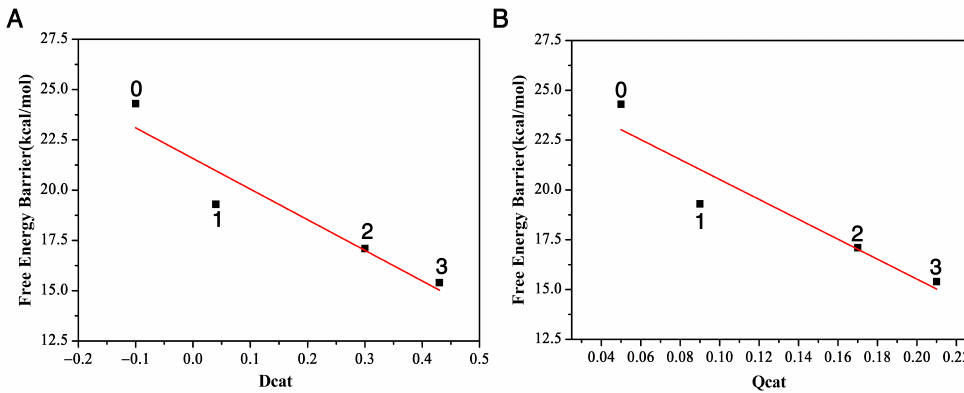
Figure 4. The relationship between the free energy barriers and the two descriptors, D cat ( A ) and Q cat ( B ), with three, two, one, and zero residues, respectively.